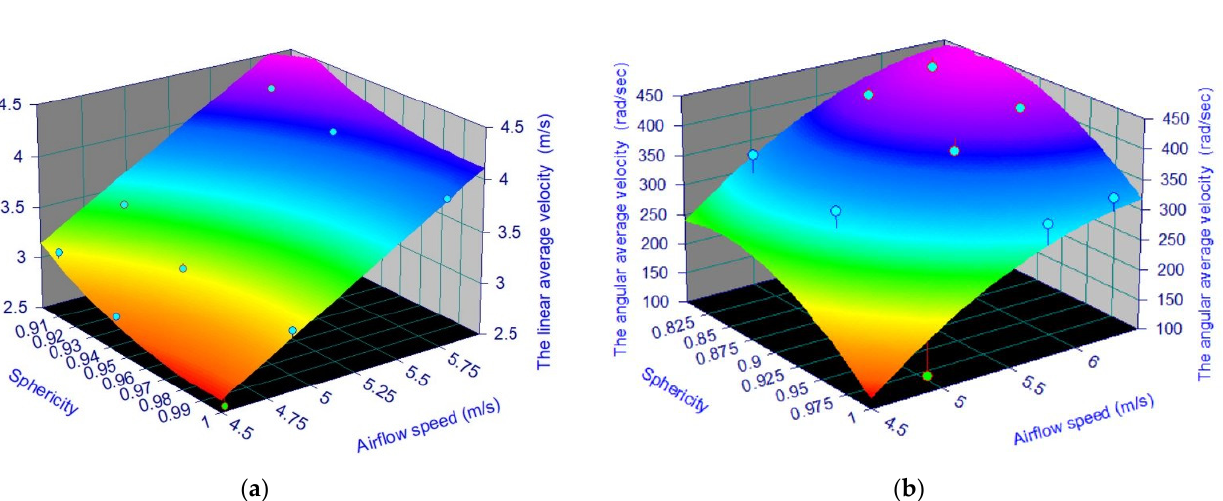
Table 2. The correlation coefficients r 2 value for both speeds